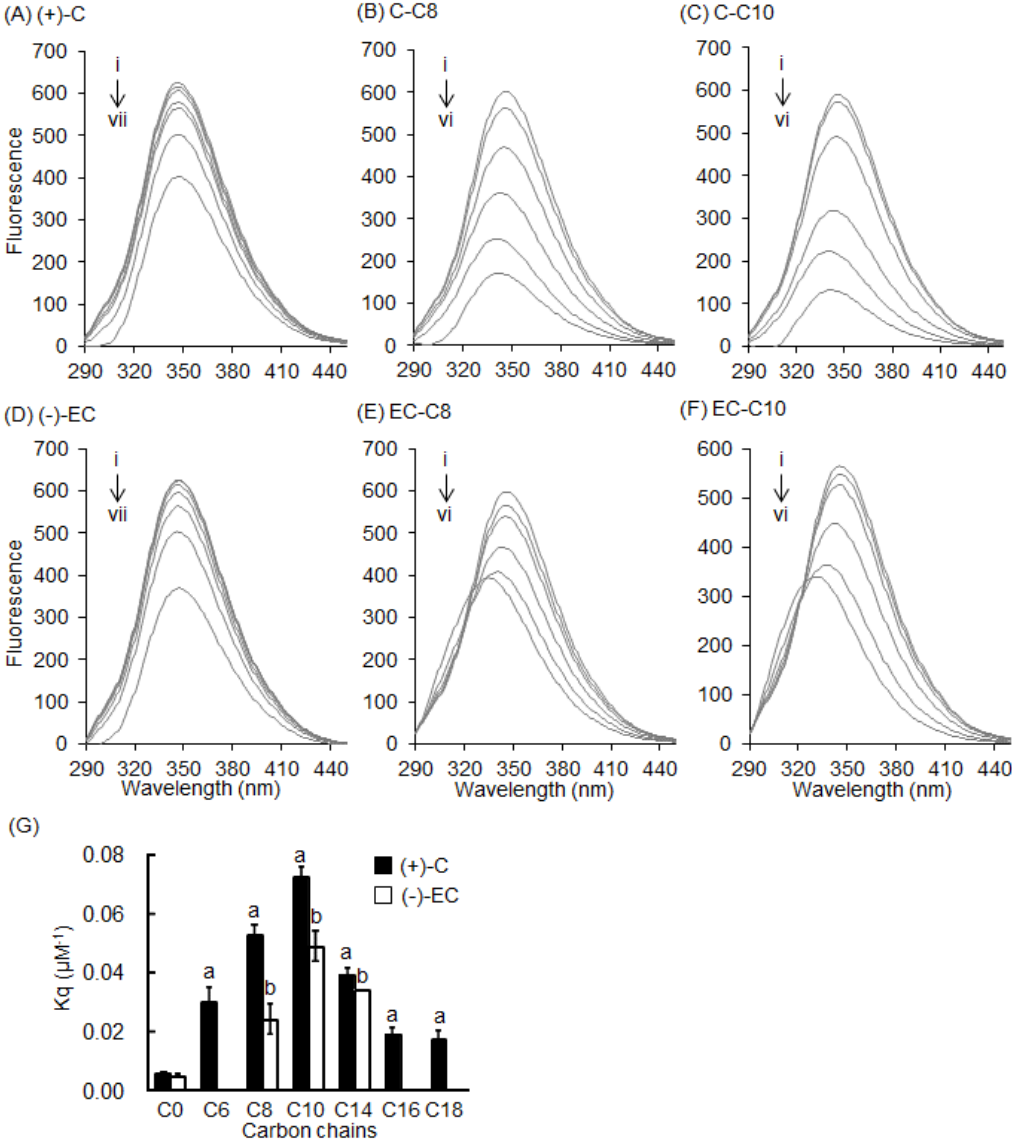
Figure 5. Effects of catechins and 3 ‐ O ‐ acyl ‐ catechins on fluorescence of BSA. Fluorescence spectra of 0.3 mg/mL BSA with various concentrations of ( A ) (+) ‐ C, ( B ) C ‐ C8, ( C ) C ‐ C10, ( D ) ( − ) ‐ EC, ( E ) EC ‐ C8, and ( F ) EC ‐ C10 were measured at an excitation wavelength of 280 nm. Symbols i to vii show the spectra of BSA with increasing quencher concentrations of 0, 1, 5, 12.5, 25, 50, and 100 μ M, respectively. ( G ) Relationship between Kq value and chain length of 3 ‐ O ‐ acyl ‐ catechins.